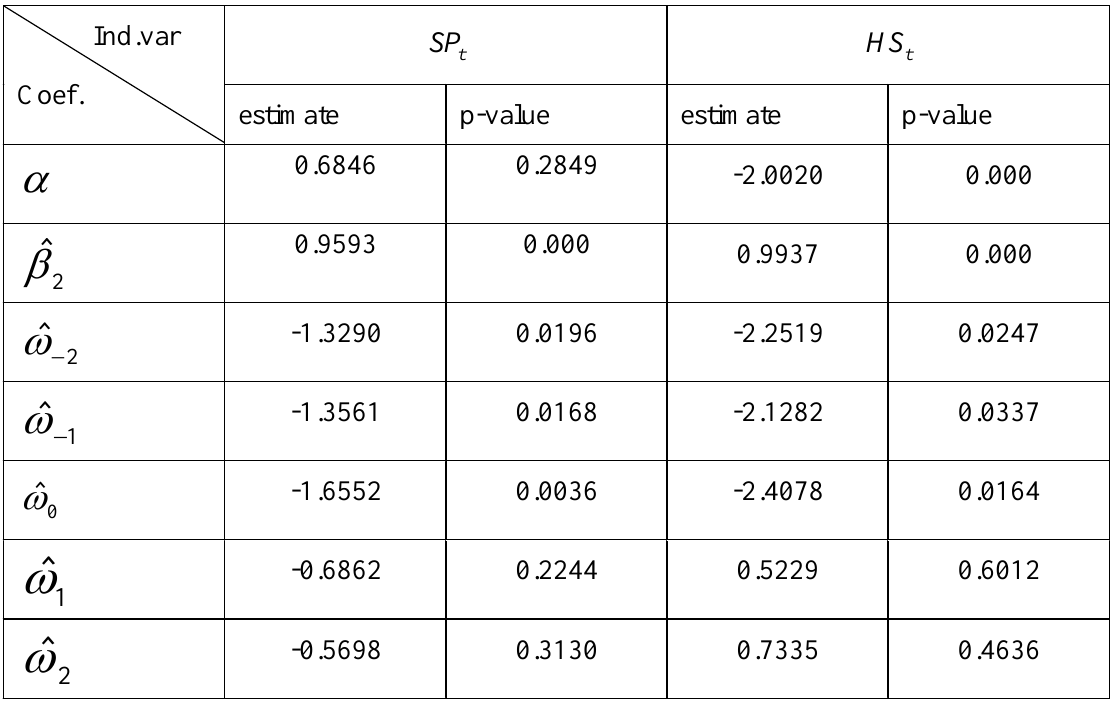
SHH t HS Ind.var t